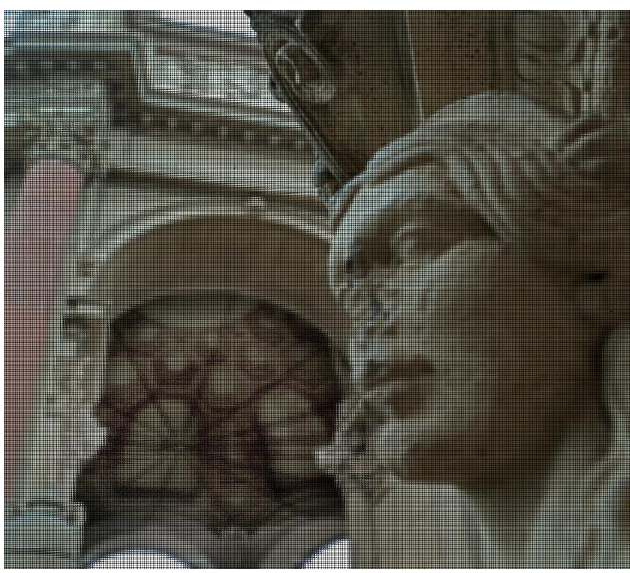
Figure 8. Original plenoptic